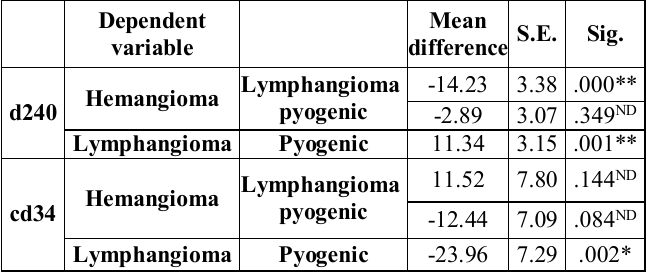
Table 4: Multiple statistical comparisons by post hoc